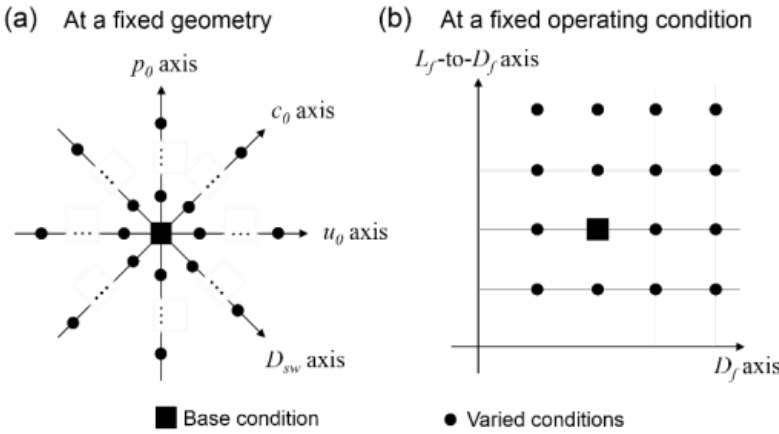
Figure 2. Schematic illustration of strategy for varying operating and geometric conditions. ( a ) at a fixed geometry ( b ) at a fixed operating condition